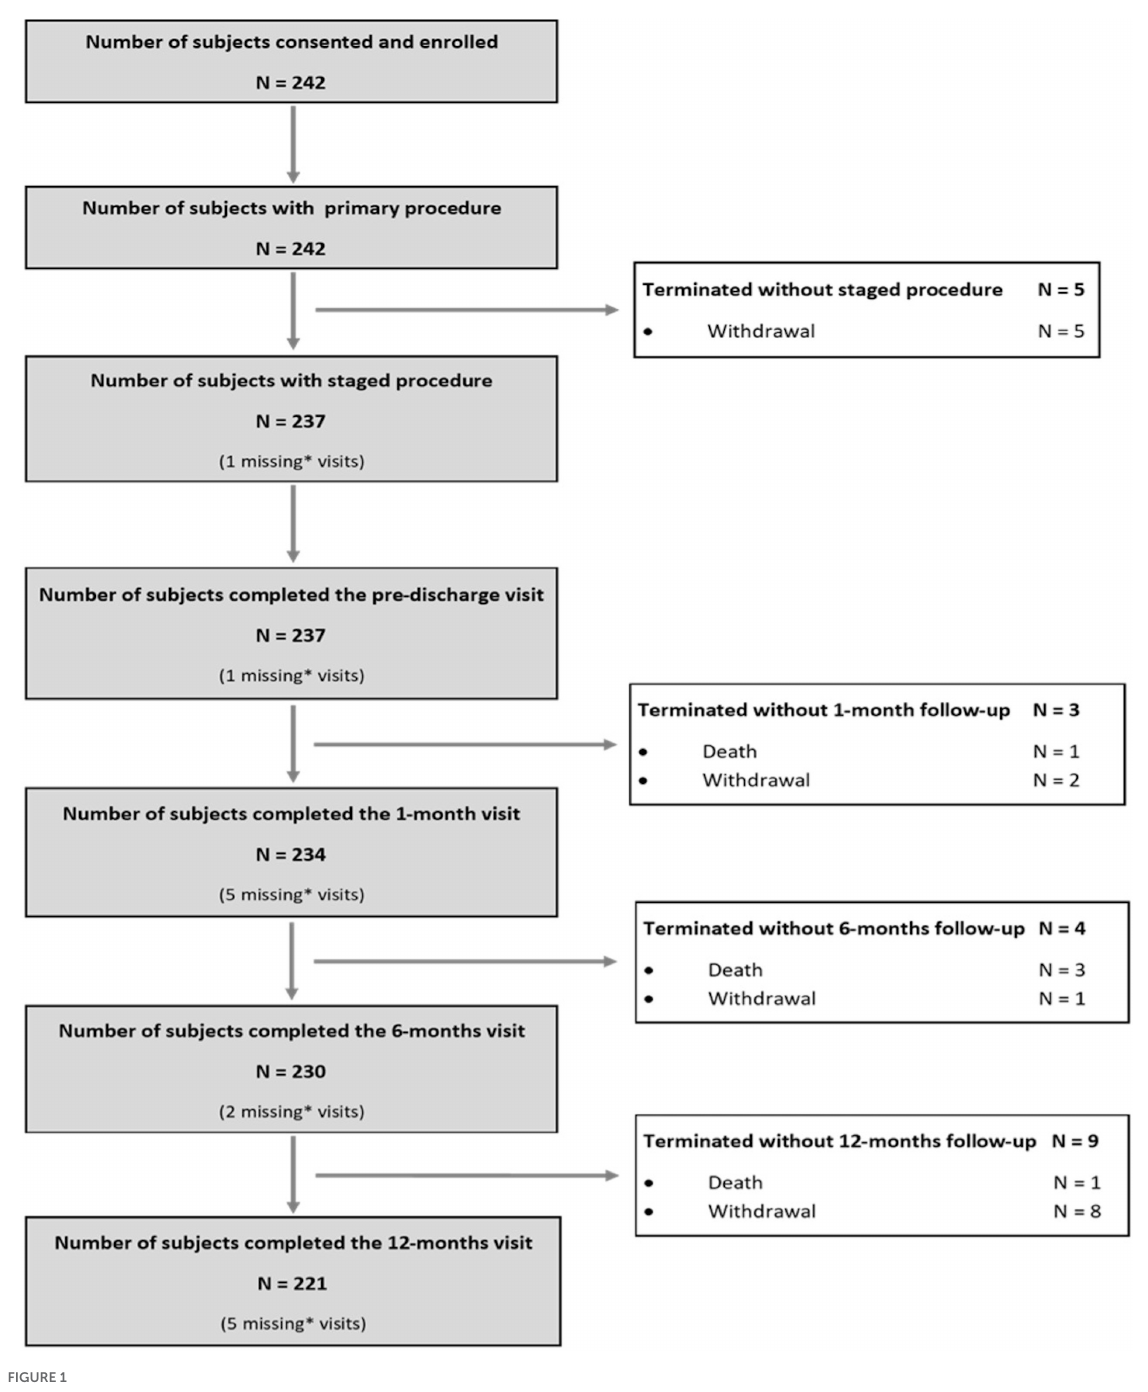
FIGURE1 Flow chart of enrolled